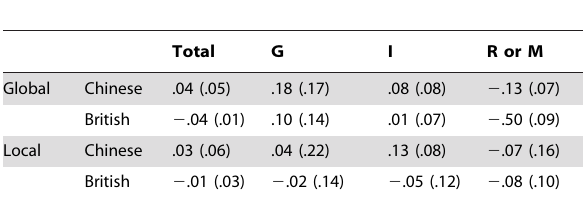
Table 5. Mean Values of B 0 for Each Attribution of Each Group in the Classification Test for Irrelevant Regularity.